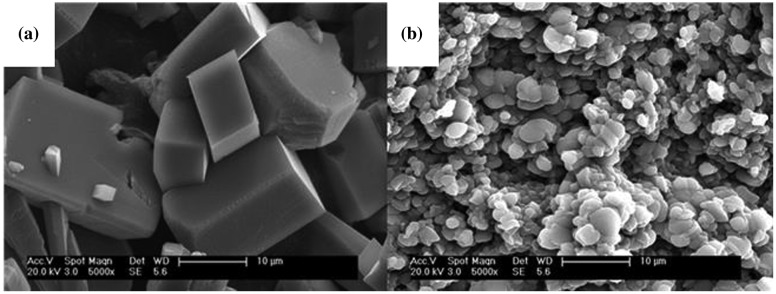
SEM images of the CaCO3 crystal formed in the absence of MA/APEG-PG-(OH)5 copolymer (a) and with the presence of 6 mg/L MA/APEG-PG-(OH)5 copolymer (b).